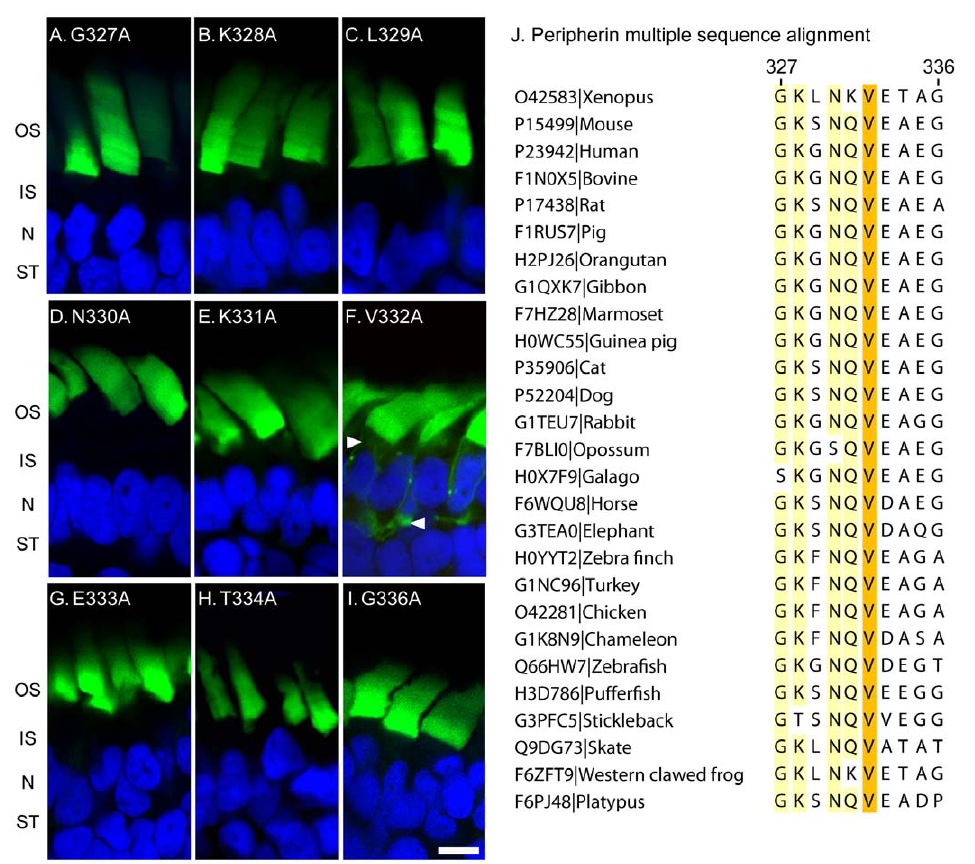
Figure 2. Alanine scanning mutagenesis of the peripherin targeting sequence identifies V332 as the only residue essential for targeting. Panels A–I show confocal images of transgenic frog retinas expressing the YFP-xRhoCT D 5-xPer317–336 (green) variations containing single alanine substitutions of individual residues. (J) Multiple sequence alignment of peripherin targeting sequences from different species; residues with over 90% identity are highlighted yellow and the 100% conserved valine is highlighted orange. Abbreviations are: OS – outer segment, IS – inner segment, N – nuclei, ST – synaptic termini. Nuclei (blue) are stained with Hoechst. Scale bar 5 m m.